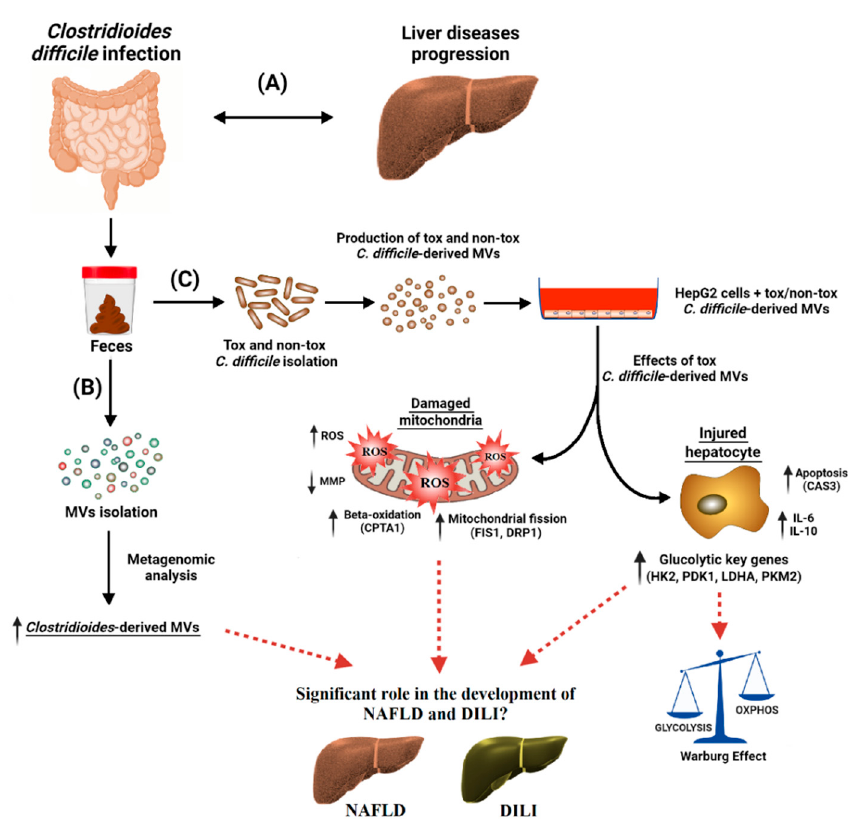
Figure 8. Clostridioides difficile infection (CDI) has been found to be associated with a broad range of liver diseases (A). Membrane vesicles (MVs) were isolated from the feces of CDI patients, and the microbiome profiling of these MVs was performed by metagenomic analysis. Clostridioides -derived MVs were present in a higher percentage (B). For the in vitro study (C), toxigenic (tox) and non- toxigenic (non-tox) C. difficile strains were isolated and cultured in the laboratory and the MVs that they produced were isolated. These C. difficile -derived MVs were internalized by HepG2 cells, with significant effects on mitochondrial function and gene expression. Toxigenic C. difficile -derived MVs decreased mitochondrial membrane potential (MMP) and increased intracellular reactive oxygen species (ROS). They also increased the expression of mitochondrial fission (FIS1 and DRP1), antiox- idant (GPX1), apoptosis (CASP3), and beta-oxidation (CPT1A) genes, as well as pro- and anti-in- flammatory genes (IL-6 and IL-10). In addition, glycolytic key genes (HK2, PDK1, LDHA and PKM2) were upregulated, possibly activating the Warburg effect in HepG2 cells. Non-toxigenic C. difficile -derived MVs, on the other hand, had no effect on gene expression except for an increase in CPT1A. These findings suggest that toxigenic C. difficile -derived MVs may play a significant role in the development and progression of different liver diseases, such as non-alcoholic fatty liver disease (NAFLD) and drug-induced liver injury (DILI). These liver diseases seem to share molecular mech- anisms related to mitochondria. The mechanisms by which these MVs influence hepatic gene ex-